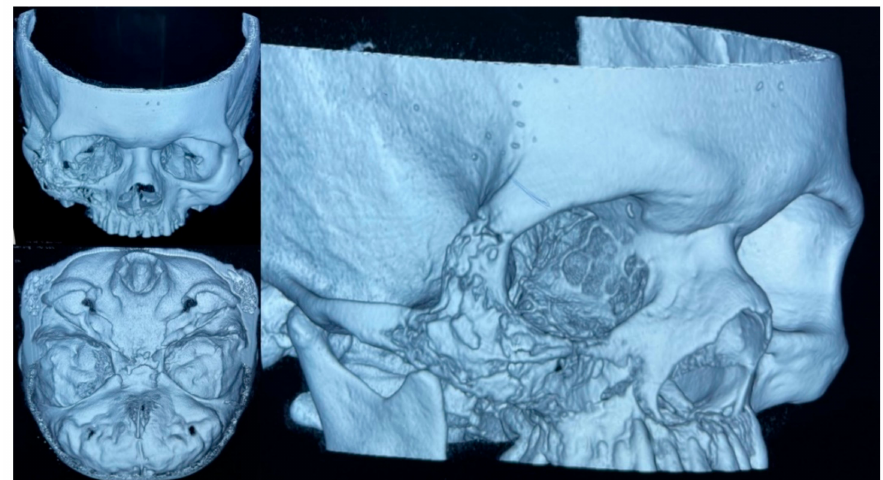
Figure 5. A 3D multislice CT-scan of the head showed the mucormycosis associated with bone